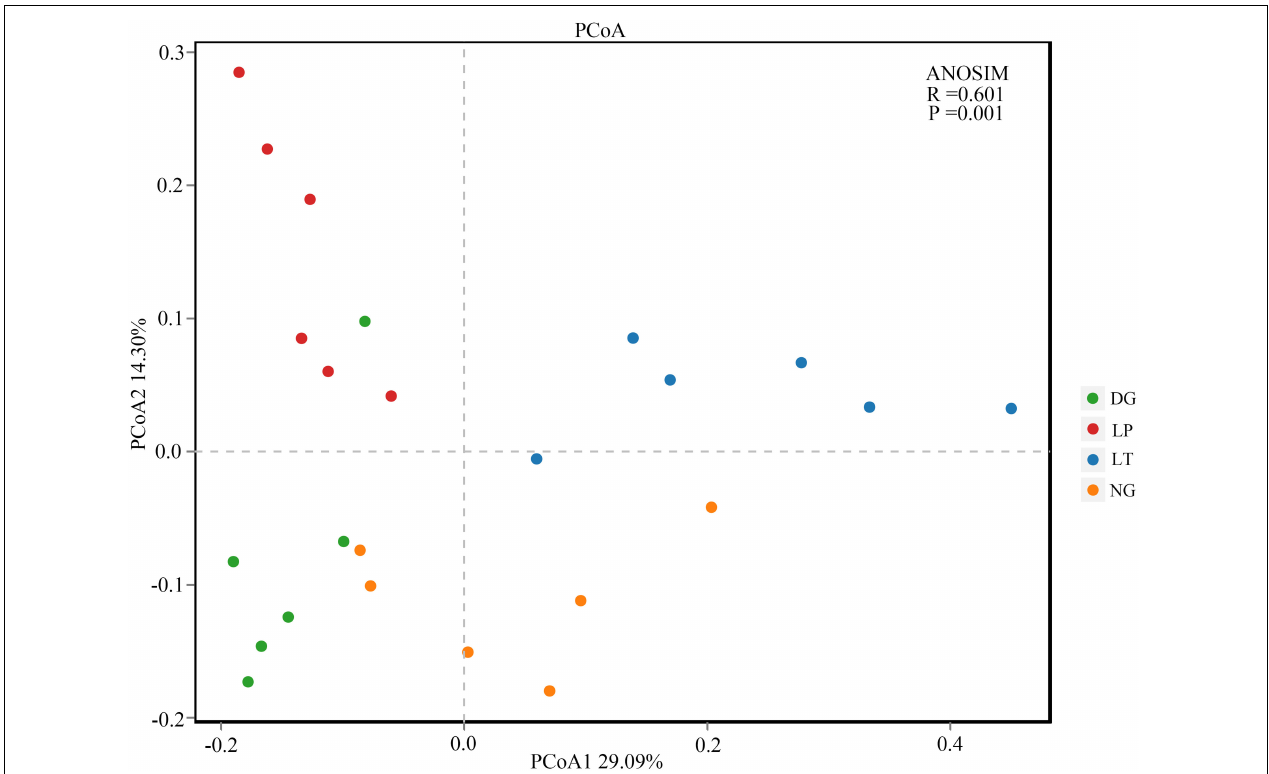
FIGURE 2 | Principal coordinates analysis of bacterial in different vegetation restorations. DG, Dactylis glomerata ; LP, Lolium perenne ; LT, Trifolium repens ; NG, natural